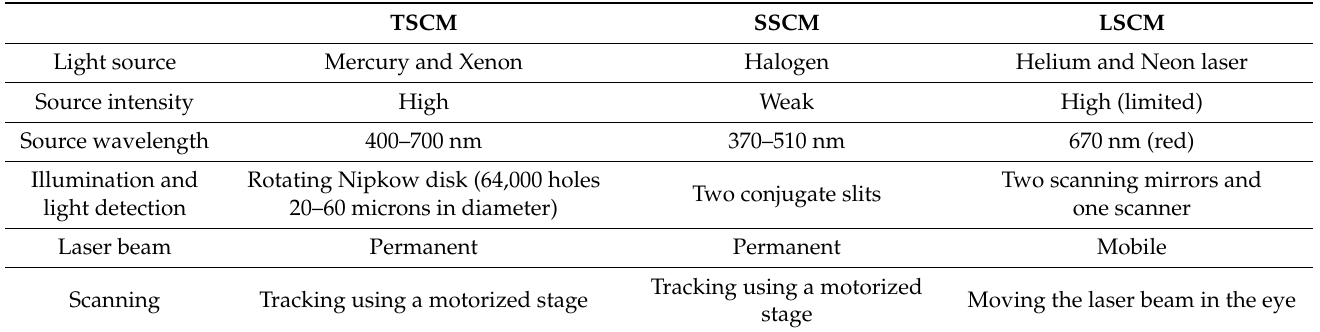
Table 1. Main characteristics of the available in vivo corneal confocal microscopes.